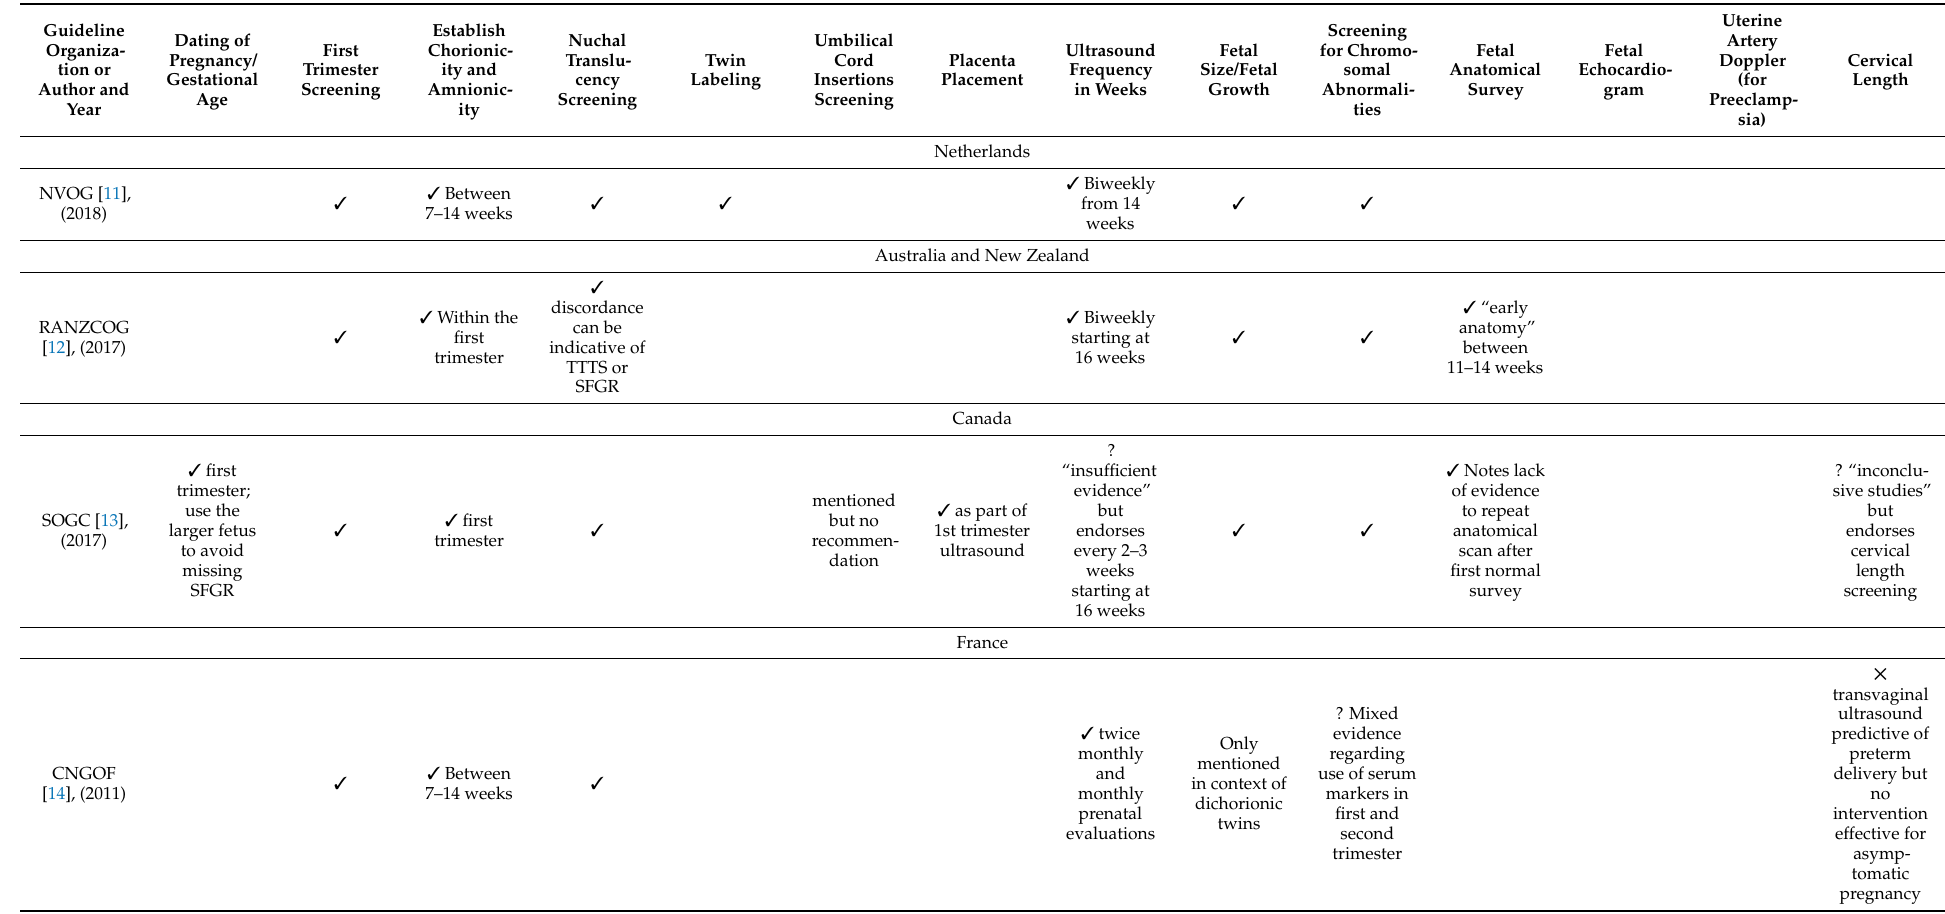
Table 2. Clinical Practice Guidelines for General Screening during Monochorionic